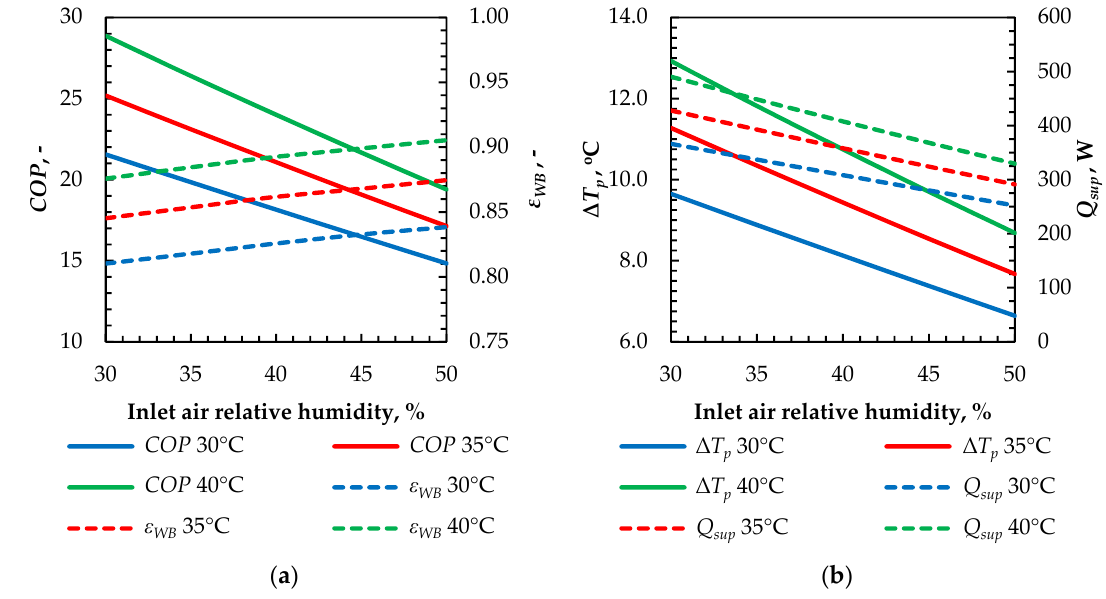
Figure 8. Impact of inlet air relative humidity for constant inlet air temperatures: ( a ) COP coefficient and wet bulb effectiveness; ( b ) Product air temperature difference and supply cooling capacity.